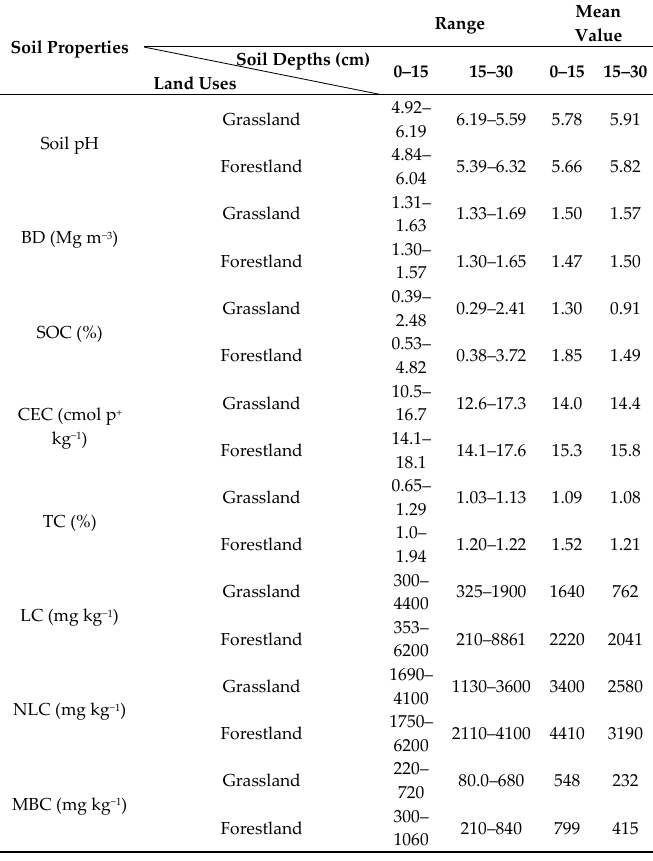
Table 3. Physical and chemical characteristics of soil in grassland and forestland from the collected studies.